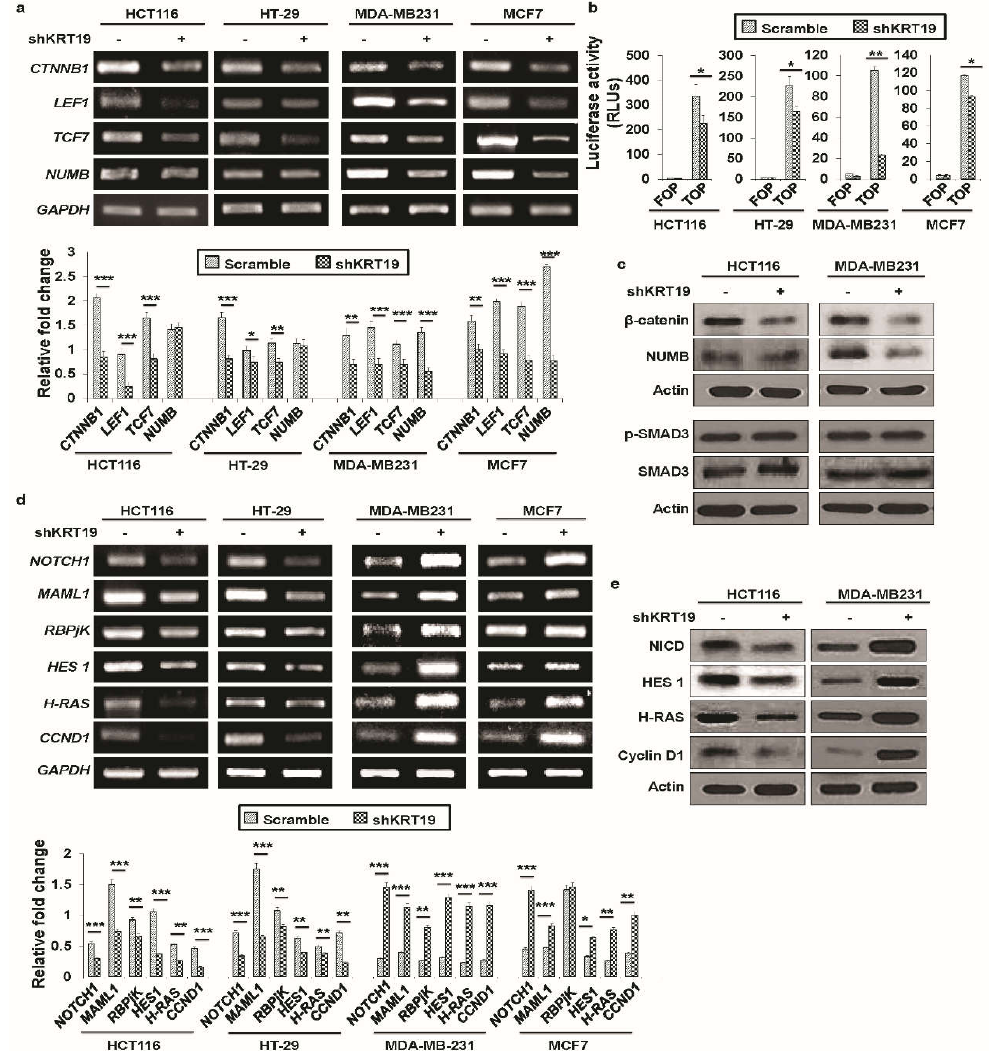
Figure 4. KRT19 differentially regulates Wnt/ β -catenin/Notch signaling in colon and breast cancers. ( a ) Expression of Wnt signaling-related genes in the indicated cells was quantified by RT-PCR. Bands were quantified by scanning densitometry analysis and normalized to that of GAPDH (lower panel). ( b ) Wnt signaling transcriptional activity was measured using a FOP- and TOP-Flash reporter assay and is shown in relative luciferase units (RLUs). ( c ) Expression of β -catenin, NUMB, p-SMAD3, and SMAD3 proteins in the indicated cells was analyzed by Western blotting. Actin was used as an internal standard. ( d ) Relative expression levels of Notch signaling-related genes in colon and breast cancer was determined by RT-PCR. Bands were quantified by scanning densitometry analysis and normalized to that of GAPDH (lower panel). ( e ) Expression of NICD, HES1, H-RAS, and Cyclin D1 proteins in the indicated cells was analyzed by Western blotting. Actin was used as an internal standard. Error bars represent ± SDs of the means of three independent experiments (* p < 0.05, ** p < 0.01, *** p < 0.001).